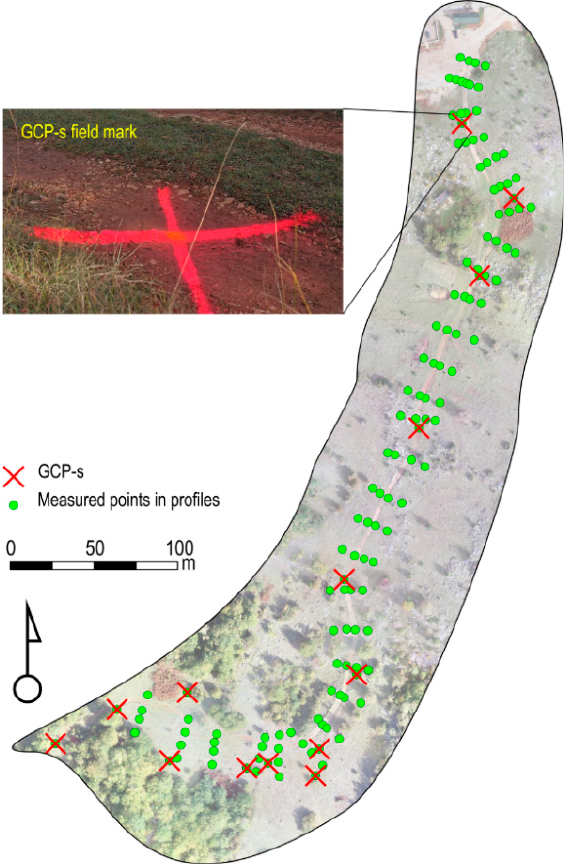
Figure 3. Positions of recorded terrain points in profiles and GCPs.